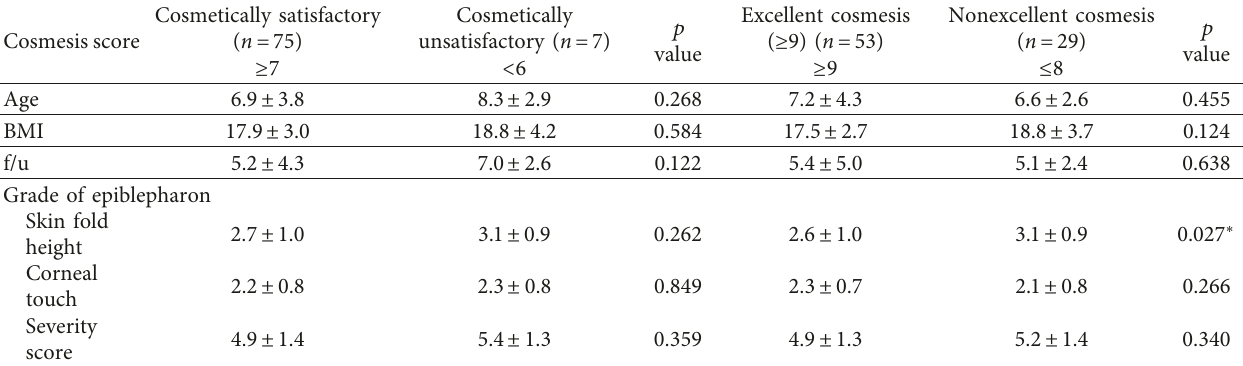
Table 3: Correlation of postoperative cosmetic satisfaction with clinical characteristics and the preoperative severity of epiblepharon. Cosmesis score